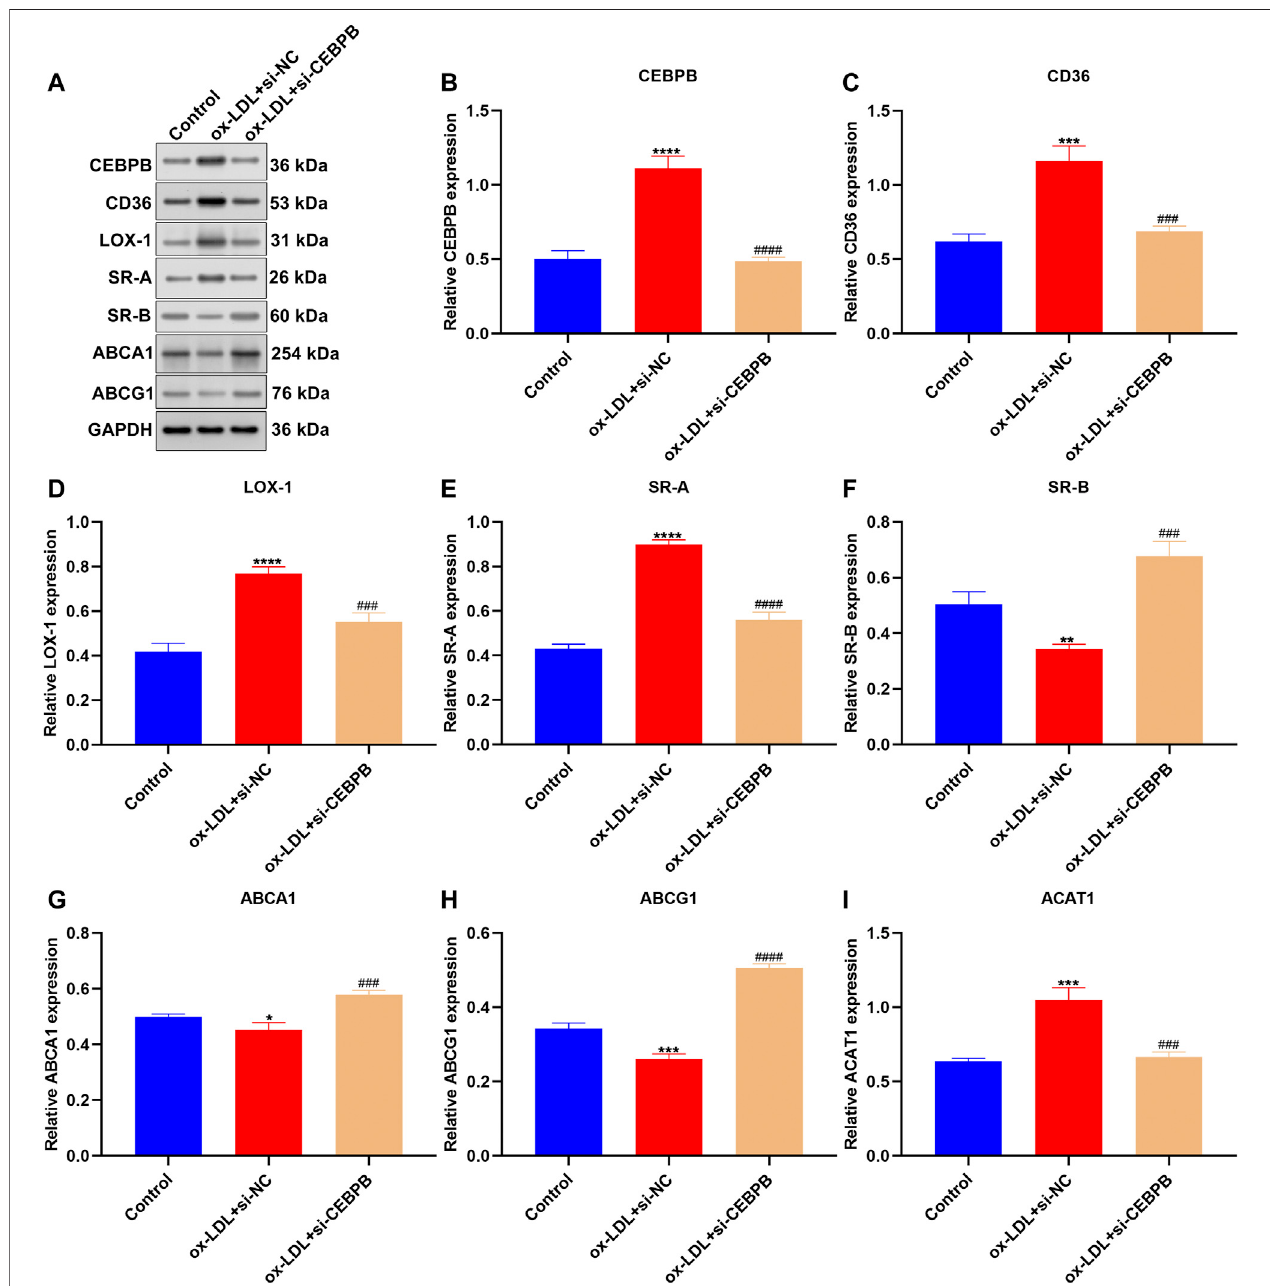
FIGURE 9 | CEBPB knockdown weakens cholesterol uptake, esteri fi cation and hydrolysis, and ef fl ux in ox-LDL – induced macrophages. (A – I) Western blotting was adopted for detection of the expression of CEBPB, CD36, LOX-1, SR-A, SR-B, ABCA1, ABCG1, and ACAT1 in ox-LDL – induced